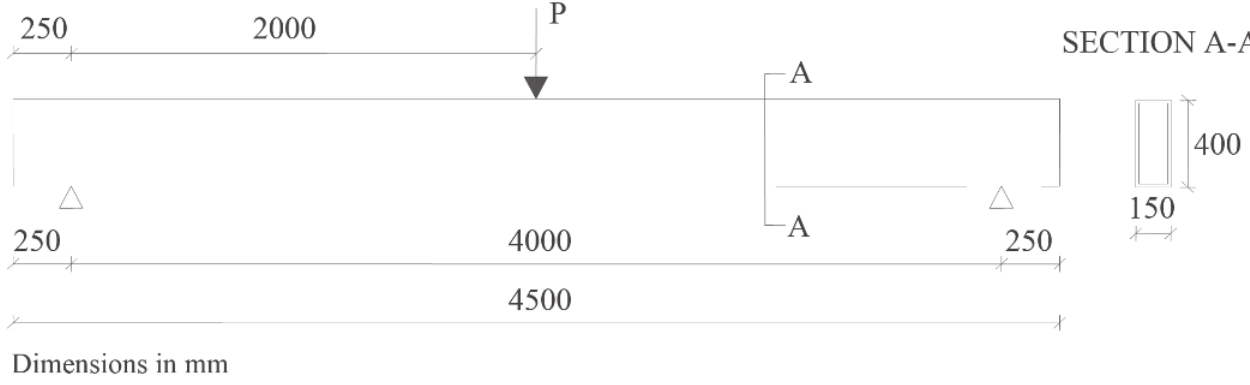
Geometrical characteristics of beams before